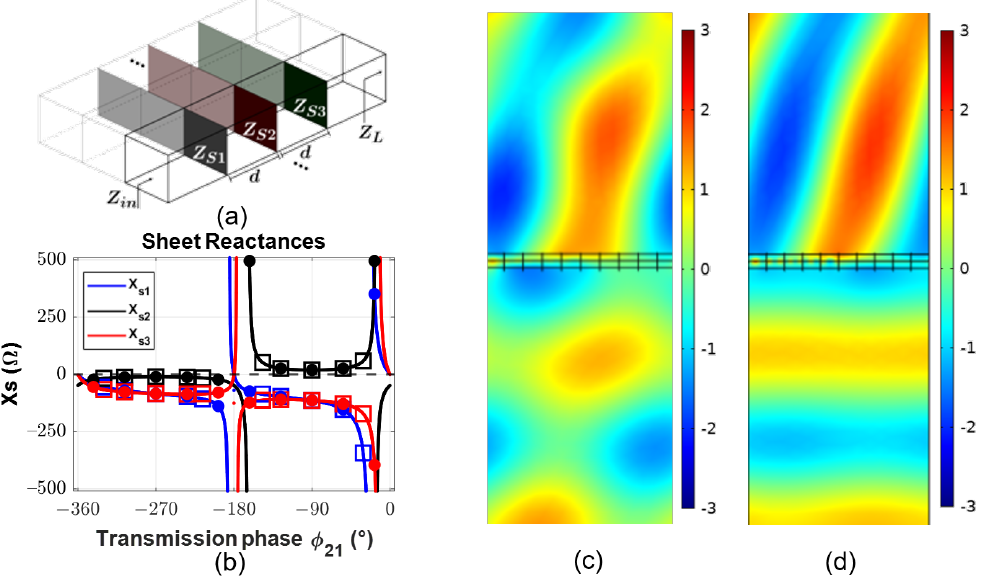
Figure 7. ( a ) The depiction of an inhomogeneous, bi-isotropic metasurface implemented as a three- sheet cascade in free-space. ( b ) Plots of the sheet reactances for different transmission phases. The solid circles indicate the values used for the linear phase gradient and the empty squares indicate the sheet values used for the perturbed phase gradient. ( c ) Full-wave simulation results for the real part of the electric field using the metasurface with a linear phase gradient. ( d ) Full-wave simulation results for the real part of the electric field using the metasurface with a perturbed phase gradient.